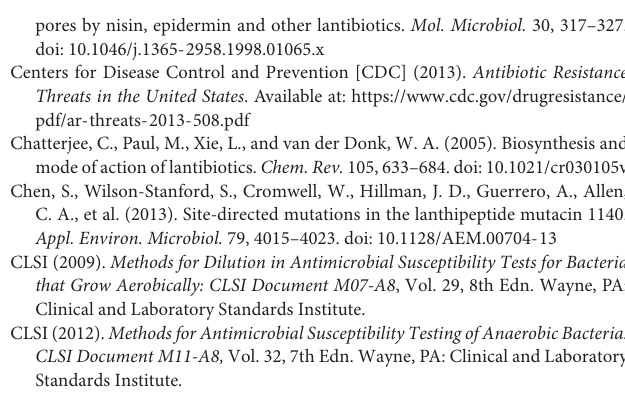
FIGURE S1 | Bacterial titers in intestinal tissues. (A) Ileum, (B) Caecum, and (C) Colon. FIGURE S2 | Toxin A and B titers at the outcome of the relapse phase or at euthanasia. Blue bar is Toxin A and Red bar is Toxin B. Limit of Detection (LOD) is 1.6 mg/mL. TABLE S1 | Complete dataset for triage